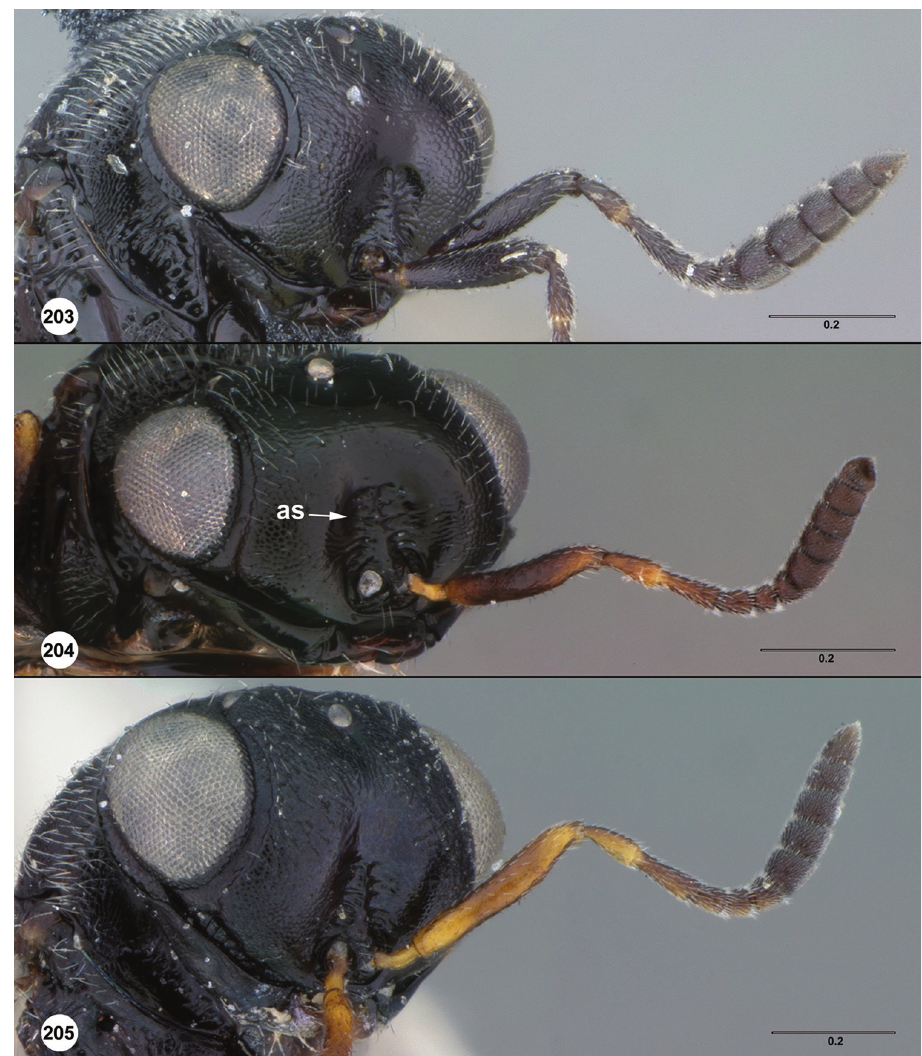
Figures 203–205. 203 Trissolcus tumidus , female holotype (NHMW 0002), head and antennae, antero- lateral view 204 Trissolcus cephalotes , female holotype (ZMAS 0142), head and antenna, anterolateral view 205 Trissolcus delucchii , female holotype (ZMAS 0148). Scale bars in millimeters.